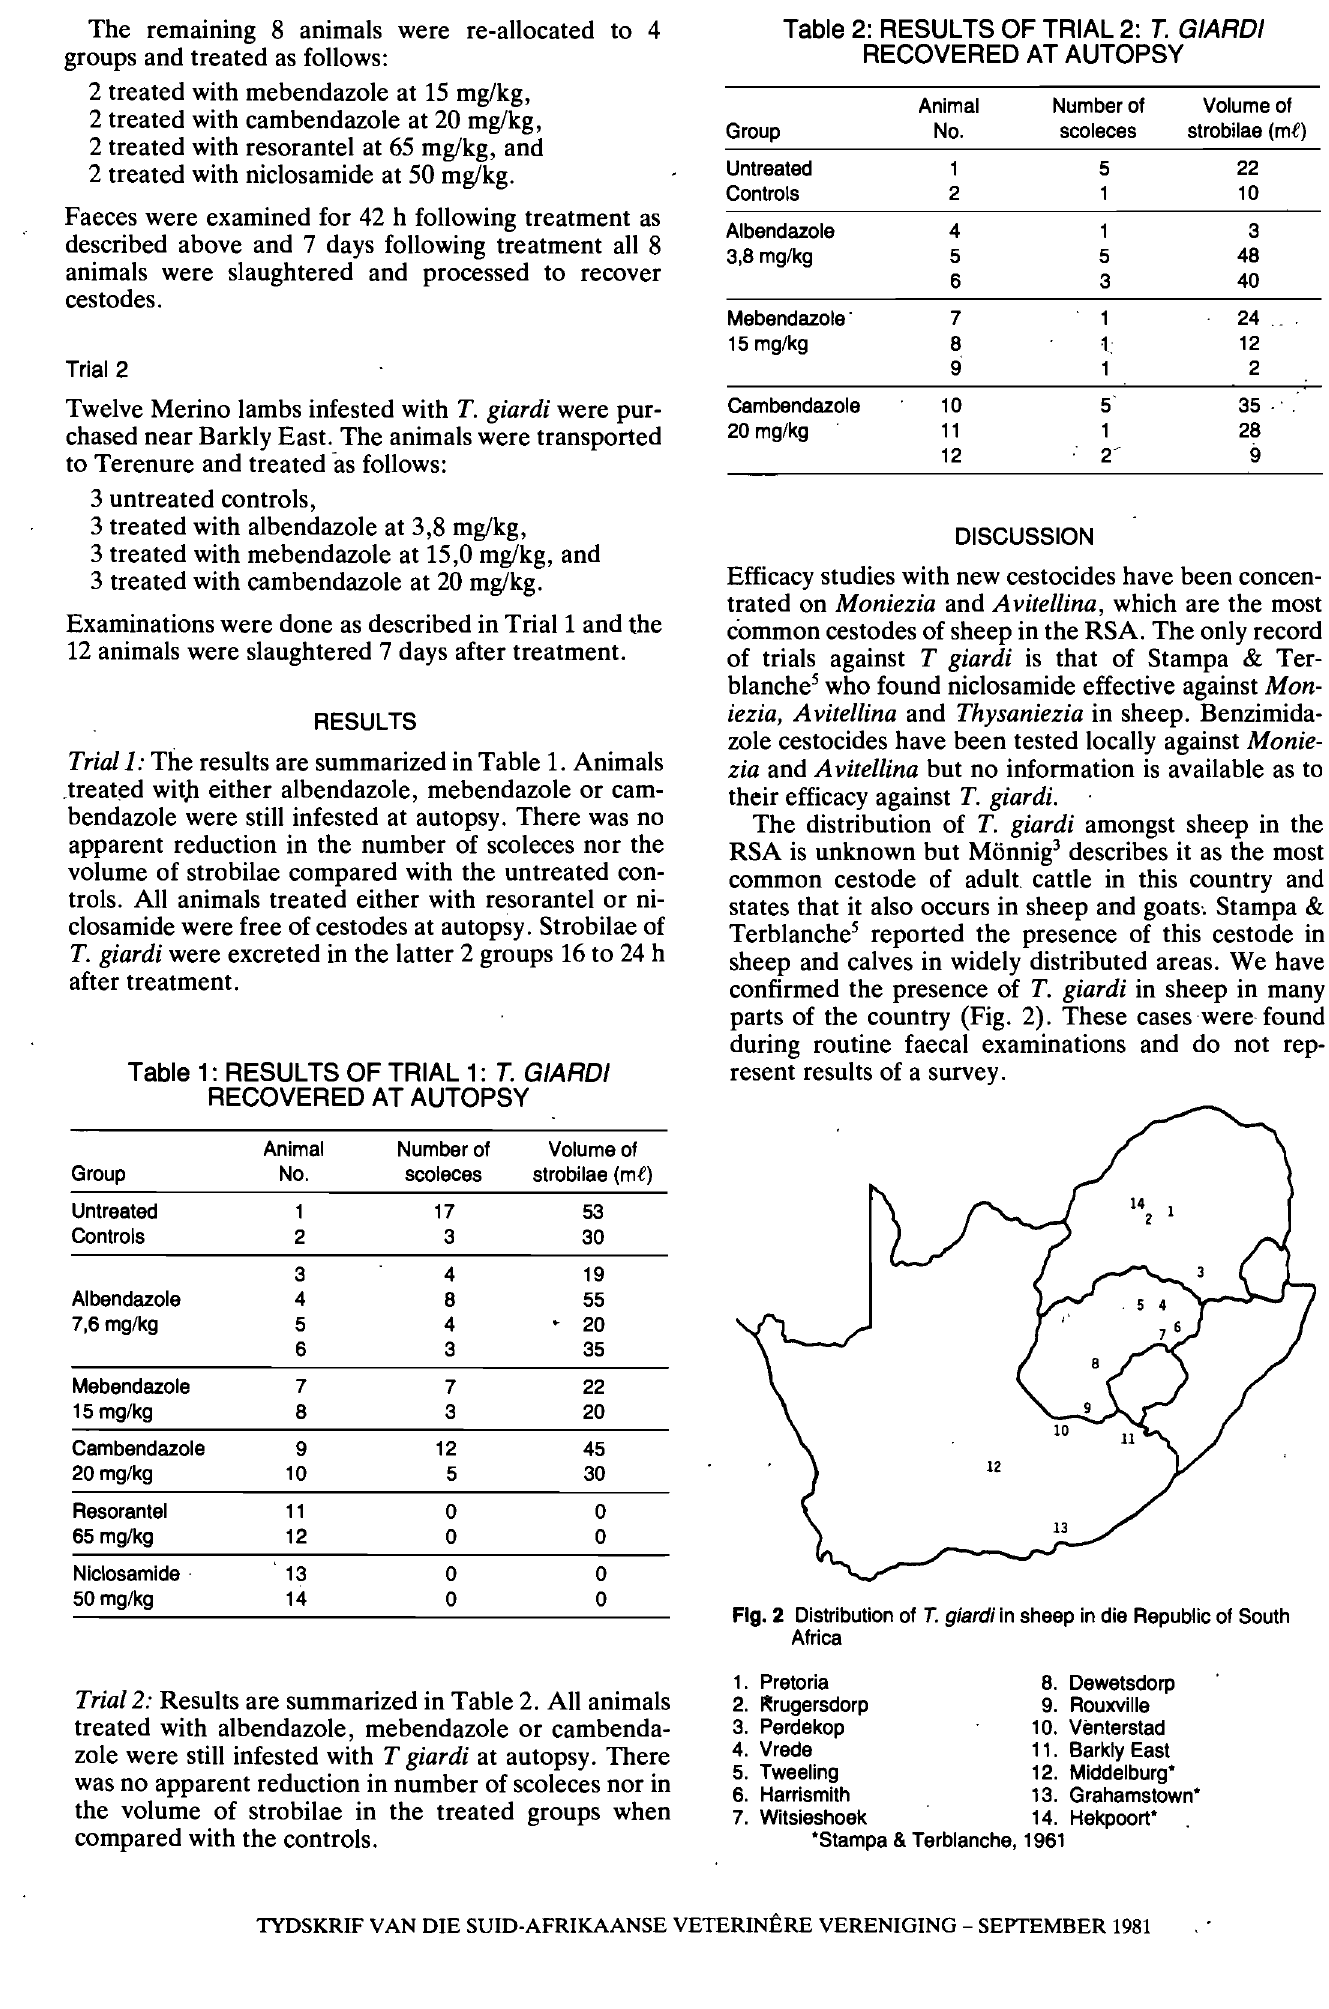
Table 2: RESULTS OF TRIAL 2: T. GIARDI RECOVERED AT AUTOPSY